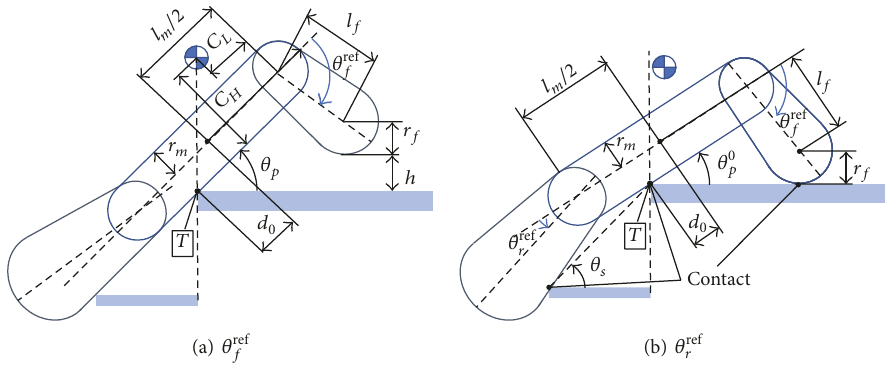
Figure 10: Target angle of subtracks in pitch-down mode.